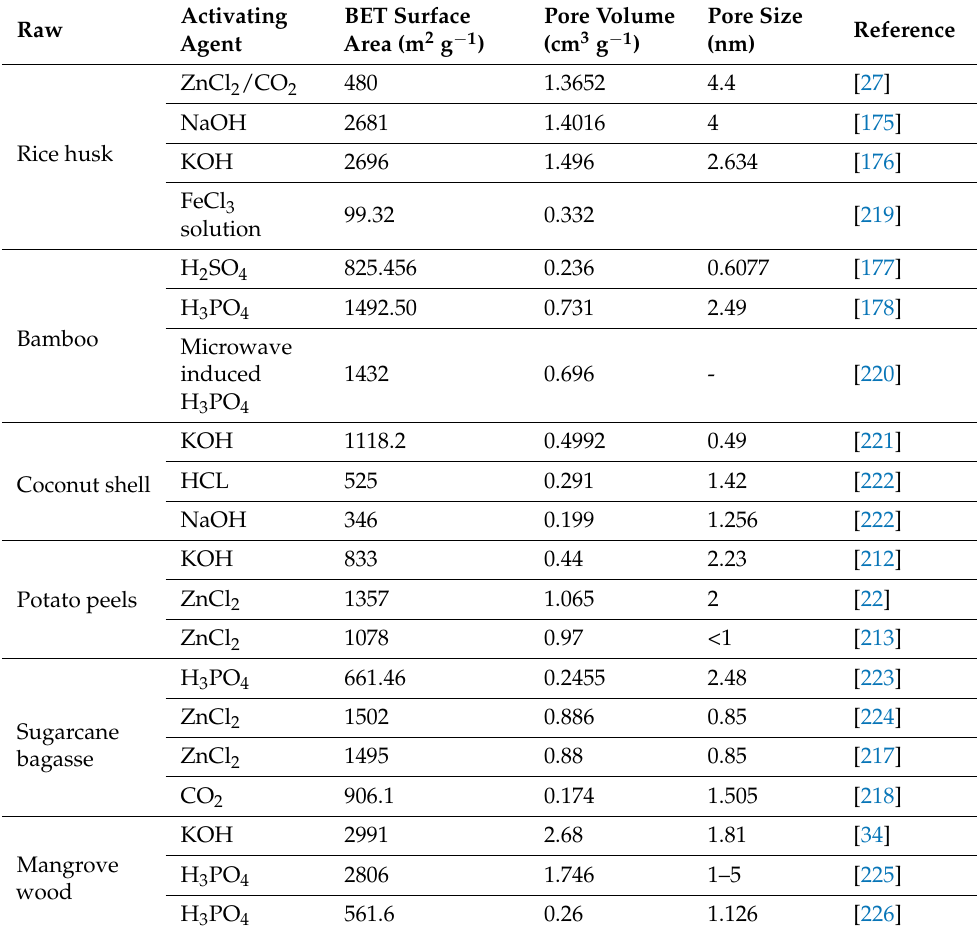
Table 7. Surface properties of activated carbon derived from different biomass precursors.